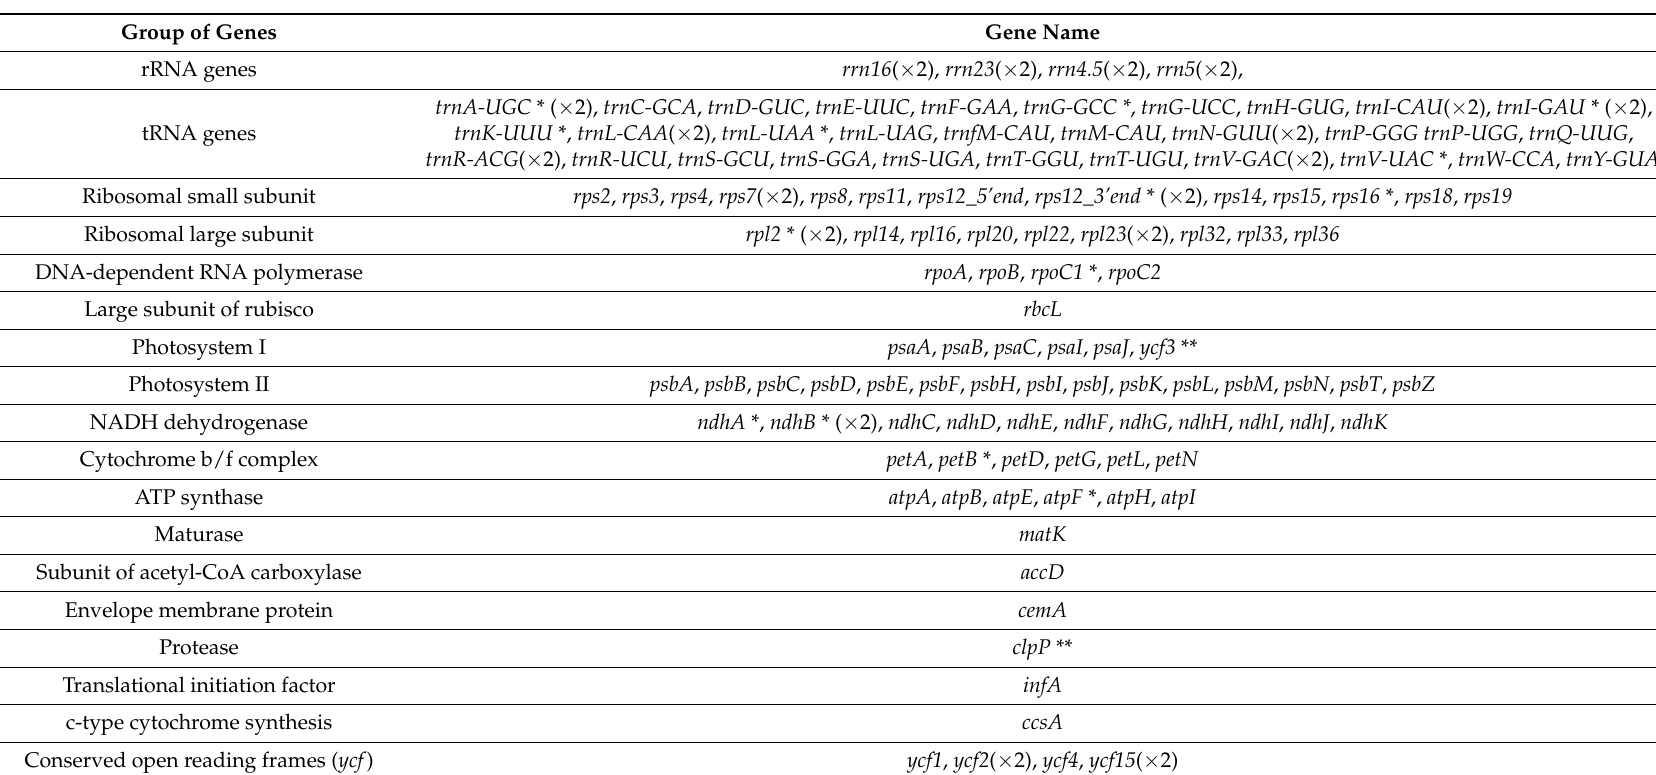
Table 2. Genes encoded in the Impatiens pinfanensis and Hydrocera triflora Chloroplast